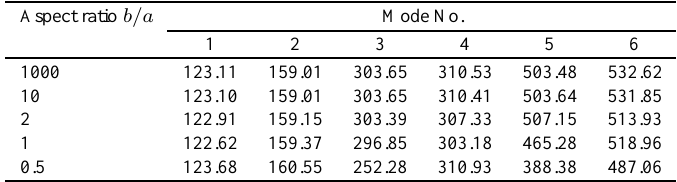
Table 2 Natural frequencies (in Hz) of Simply-Supported rectangular cross-section beam